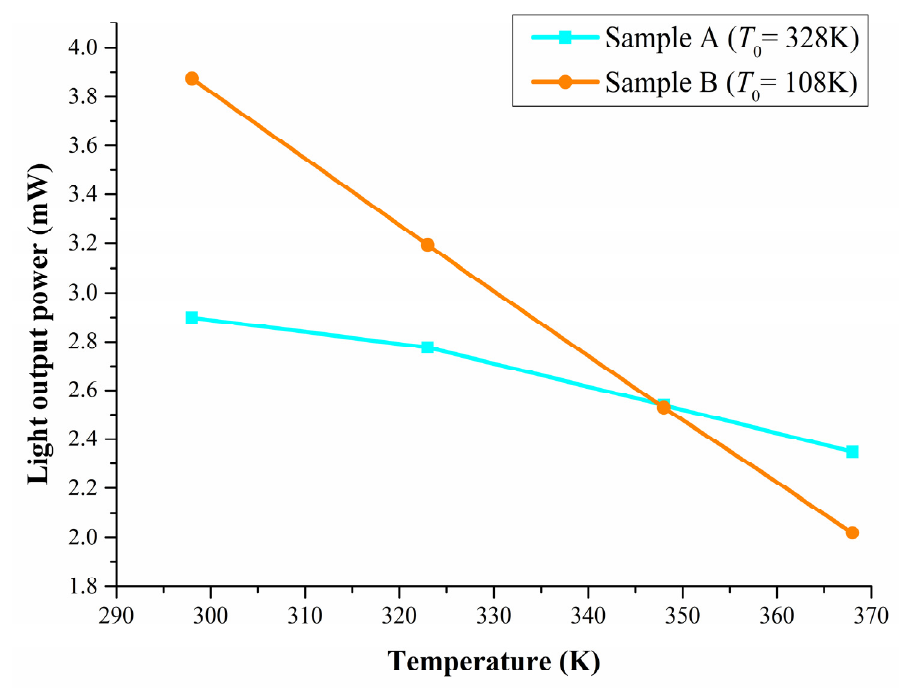
Figure 4. Light output power from samples A and B measured at various temperatures at 40